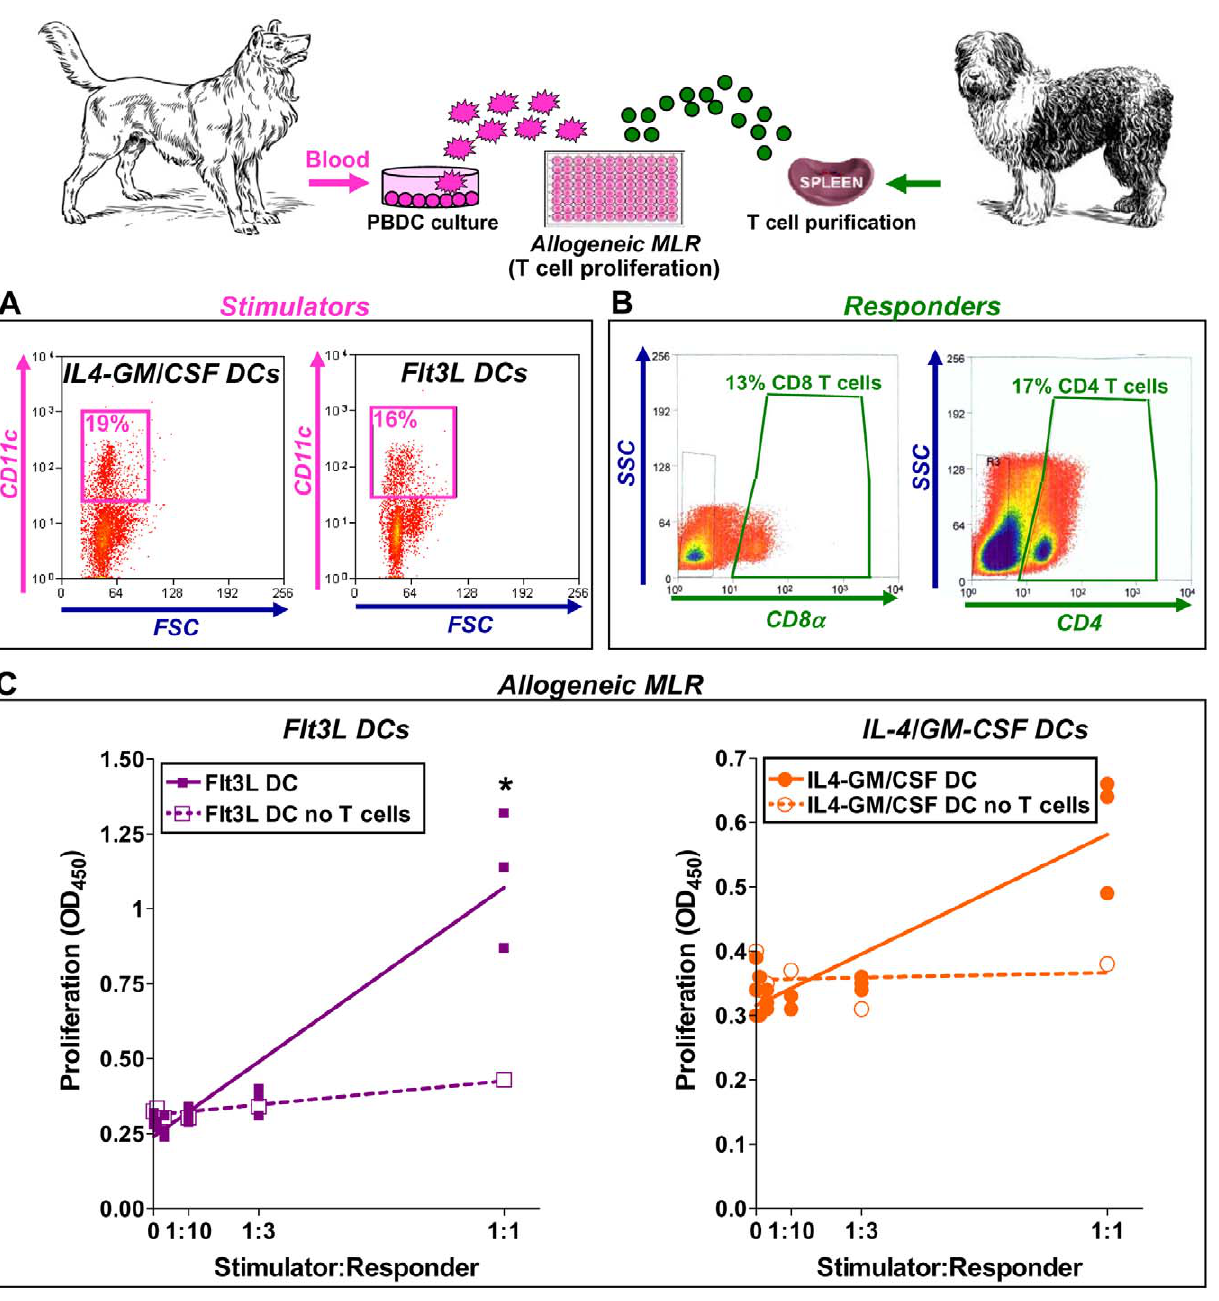
Figure 6. Allogeneic mixed-lymphocyte reaction (MLR). DCs (stimulators, A ) from dog peripheral blood monocytes cultured with either Ad.hFlt3L conditioned media (purple dots) or IL-4 + GM-CSF (orange dots) were incubated with allogeneic spleen T cells (responders, B ) purified by Fluorescence Activated Cell Sorting (FACS) from the spleen of a second dog. Dot plots show the percentage of CD11c + -cells ( A ) and the percentage of CD8 + and CD4 + T cells collected from dog spleen by FACS ( B ). SSC: Side Scatter; FSC: Forward Scatter. C , T cell proliferation was determined by BrdU incorporation after 4 days in co-culture. Additional controls included DCs incubated without T cells (broken lines). *p , 0.05 vs. DCs no T cells (Randomization